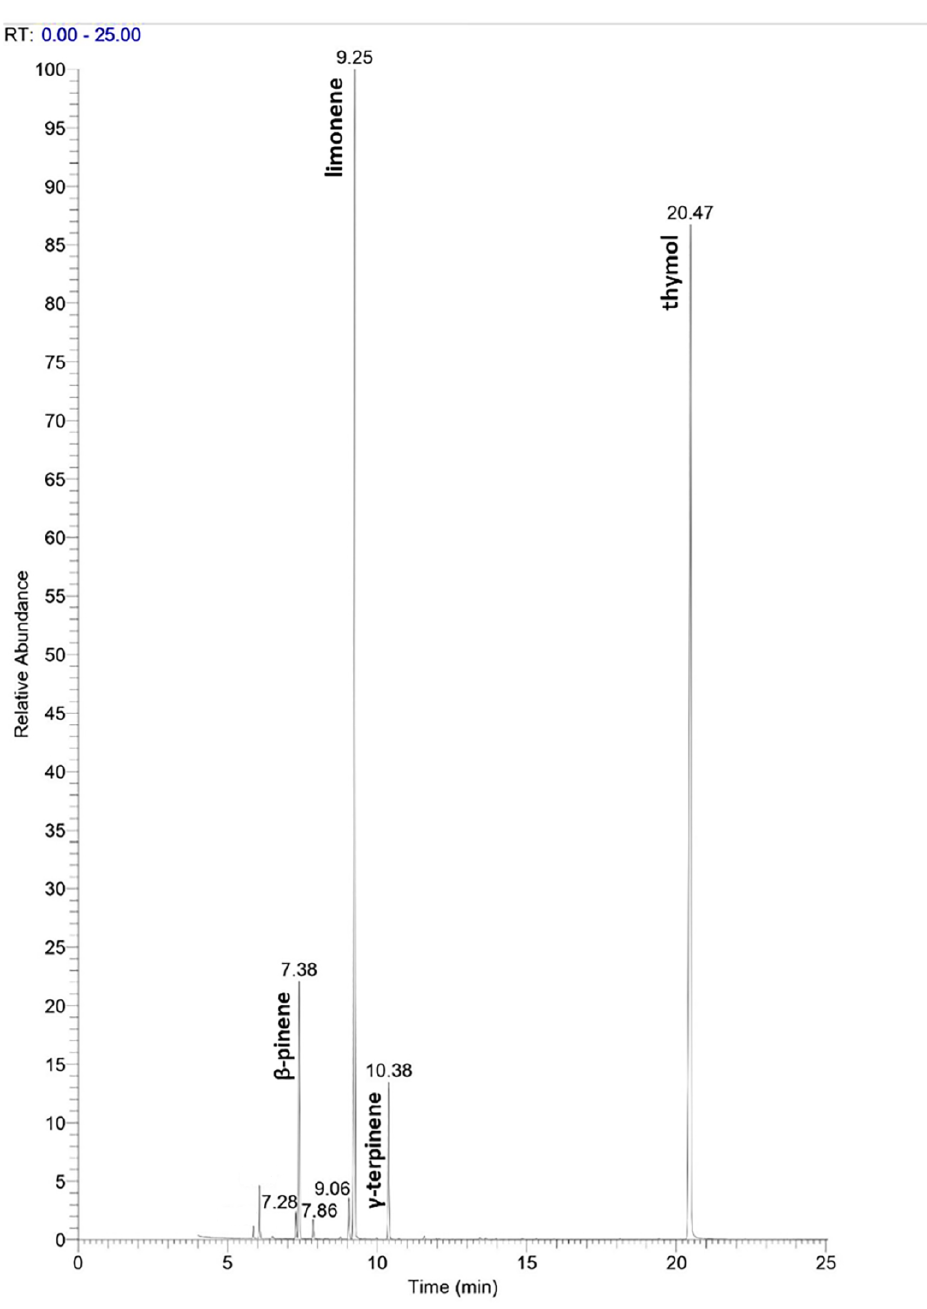
Figure 1. Gas chromatogram of the tested thyme essential oil. The most abundant components were identified through GC-MS analysis by Thermo Scientific TRACE 1310 GC system coupled to an ITQ 900 mass spectrometer and are assigned in the figure. RT, retention time. 900 mass spectrometer and are assigned in the figure. RT, retention